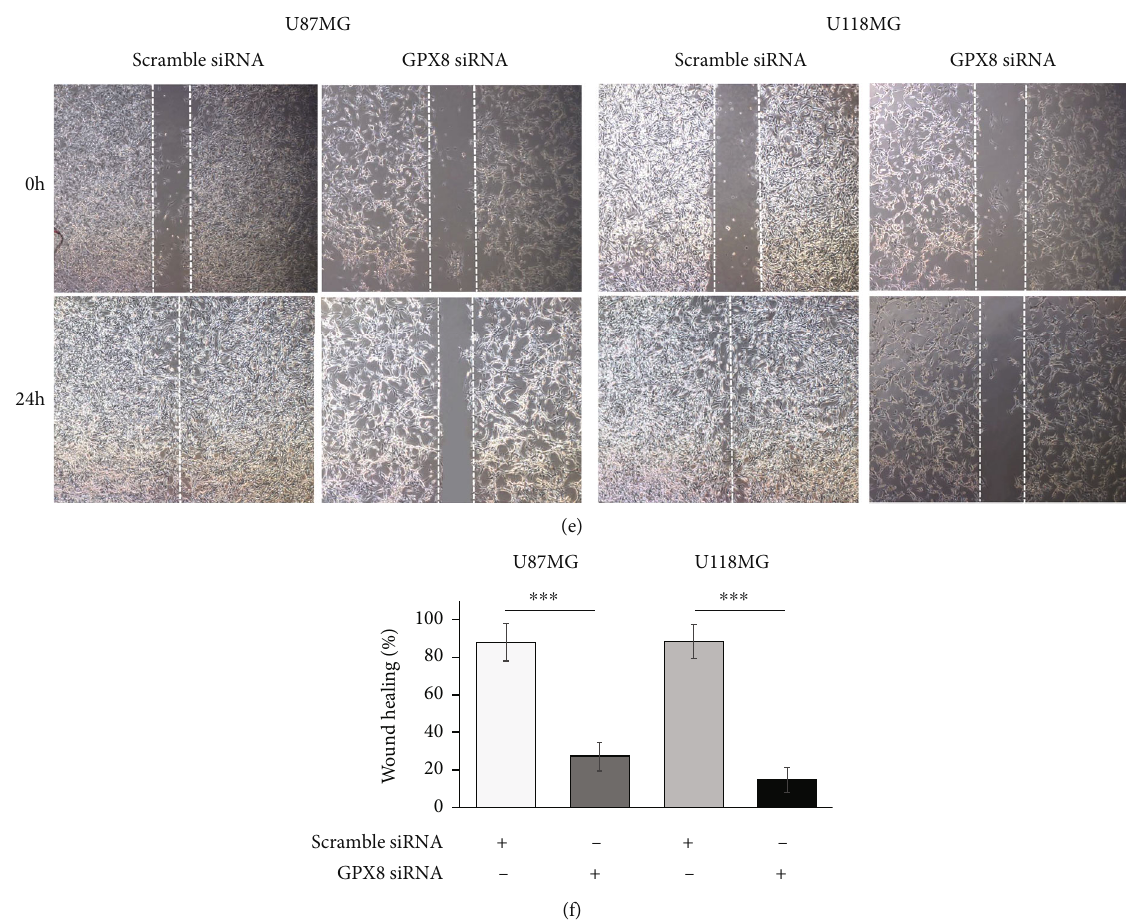
Figure 8: E ff ects of GPX8 on cell proliferation, apoptosis, and migration. (a) The decreased protein level of GPX8 in U87MG and U118 cell lines was proved by western blotting. (b) Cell proliferation assay ( ∗∗∗ P < 0 : 001 ). (c, d) Apoptosis assay ( ∗ P < 0 : 05 , ∗∗ P < 0 : 01 , and ∗∗∗ P < 0 : 001 ). REA: the rate of early apoptotic cells; RTA: the rate of total apoptotic cells; RLA: the rate of late apoptotic cells. (e, f) Wound healing assay ( ∗∗∗ P < 0 : 001 Figure 6, hedgehog (HH) signaling pathway, kras pathway,